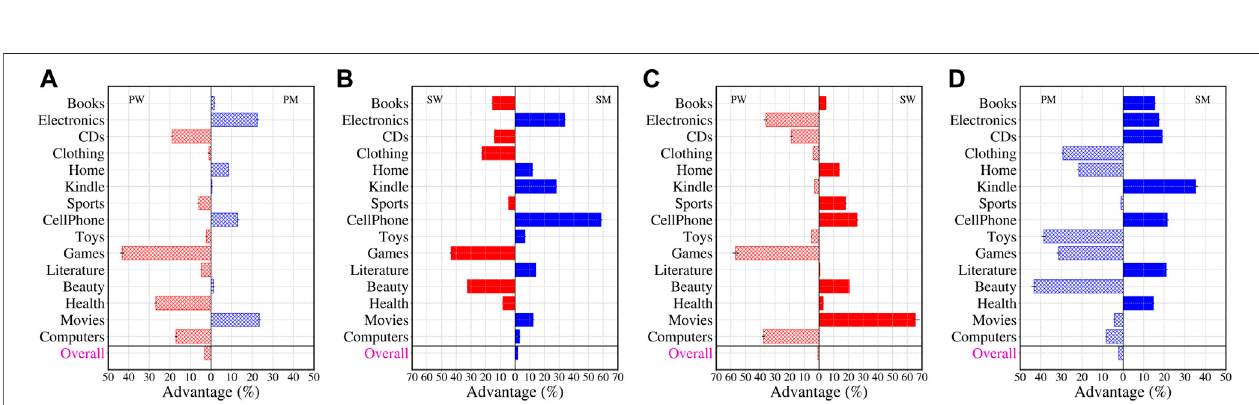
FIGURE 5 | Distribution of the matching confounders. We present the distributions of two exemplary potential confounders (A) Readability score and (B) overall rating for the reviews in the matched set across the four groups for the category Books. Note that for the two confounder (results are similar for others) the distribution acrossthefourgroupscloselyresembleeachother.Thisshowsthatthereviewsinthematchedsetareindeedsimilarandhenceinferencedrawnonthesematchedsets are consistent.